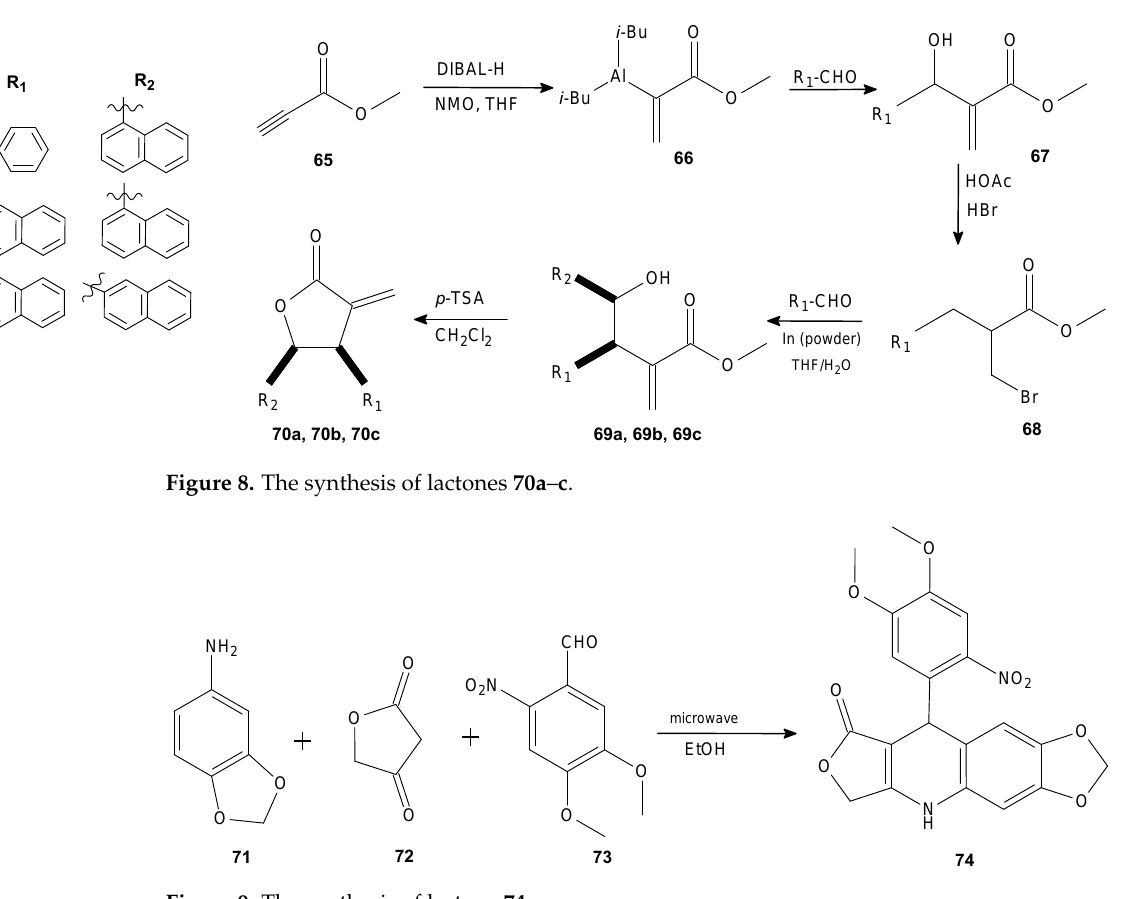
Figure 9. The synthesis of lactone 74 .